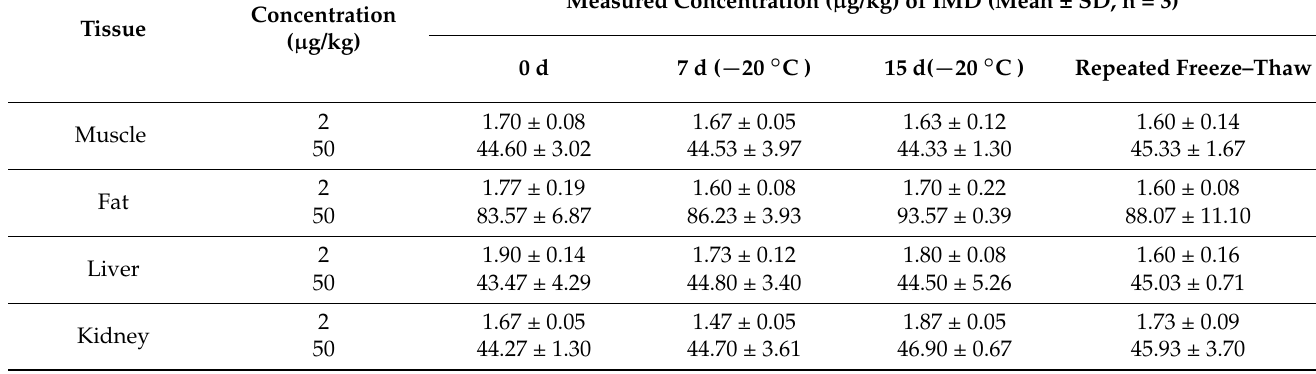
Table 4. Stability results of IMD in four tissues of cattle.